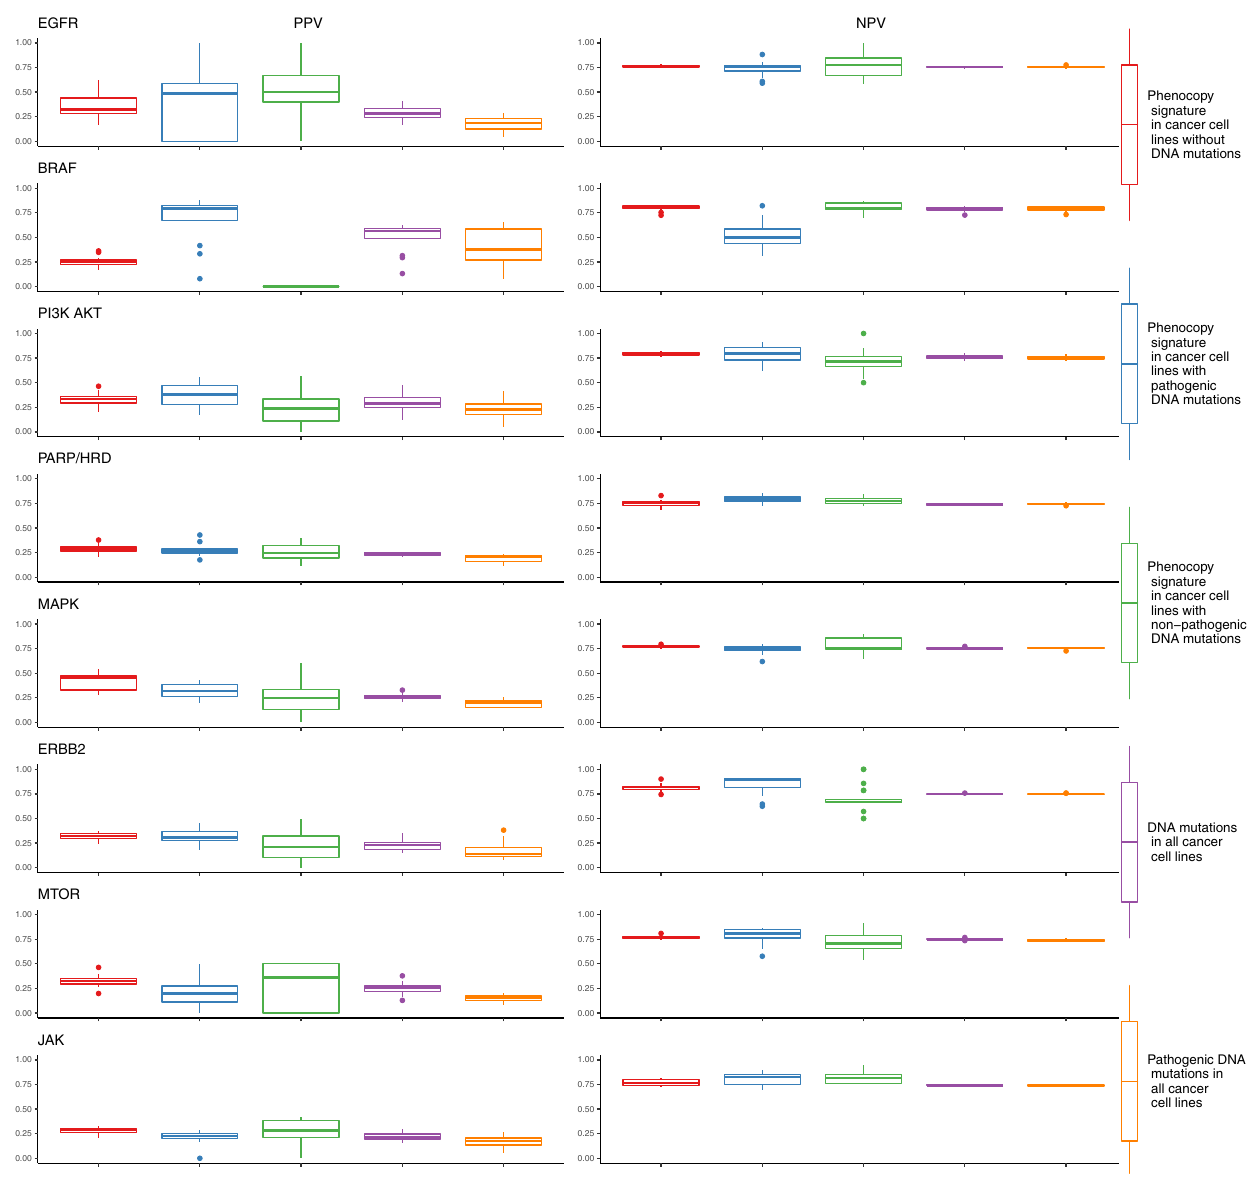
Fig. 5 Positive predictive value (PPV) and negative predictive value (NPV) of phenocopy signatures. PPV and NPV were calculated for each drug and pathway. The top quartile in drug sensitivity for each drug was considered a responder. Each data point represents a single drug in a single dataset, with the three datasets represented by different shapes. Five separate conditions were investigated: (1) phenocopy signature in cancer cell lines without DNA mutations, (2) phenocopy signature in cancer cell lines with pathogenic DNA mutations, (3) phenocopy signature in cancer cell lines with non-pathogenic DNA mutations, (4) DNA mutations in all cancer cell lines, and (5) pathogenic DNA mutations in all cancer cell lines. Boxplot center line = median value, bounds of box (hinges) = interquartile range (IQR), bounds of whiskers = maximum of 1.5X IQR from the